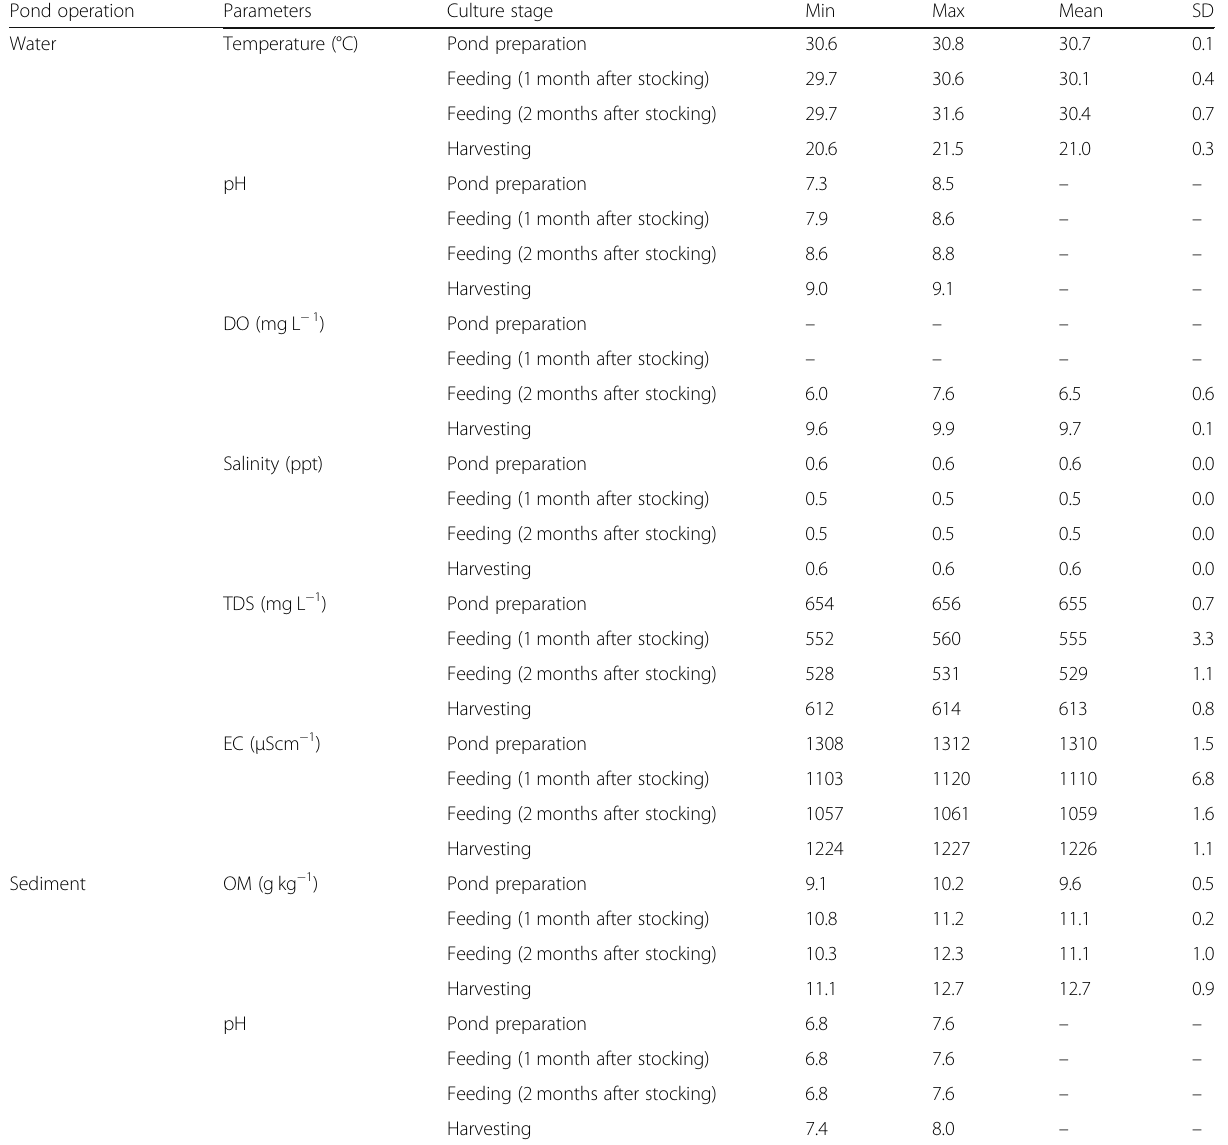
Table 1 Basic characteristics of pond water and sediment quality during an intensive whiteleg shrimp culture cycle Pond